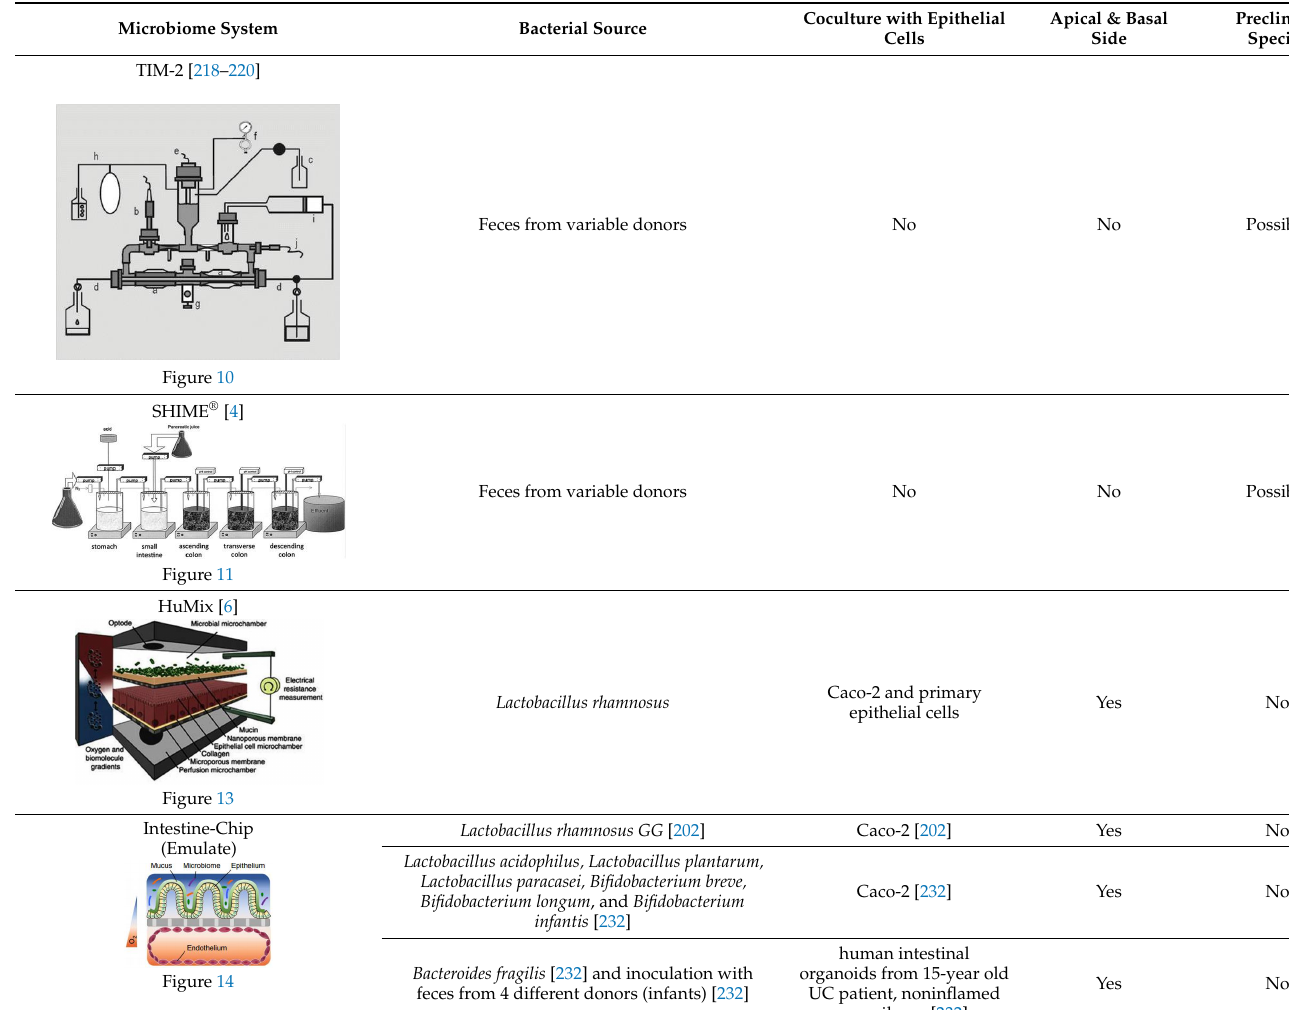
Table 4. Overview of the characteristics of intestinal in vitro tools (microbiome models) discussed in this article. Microbiome System